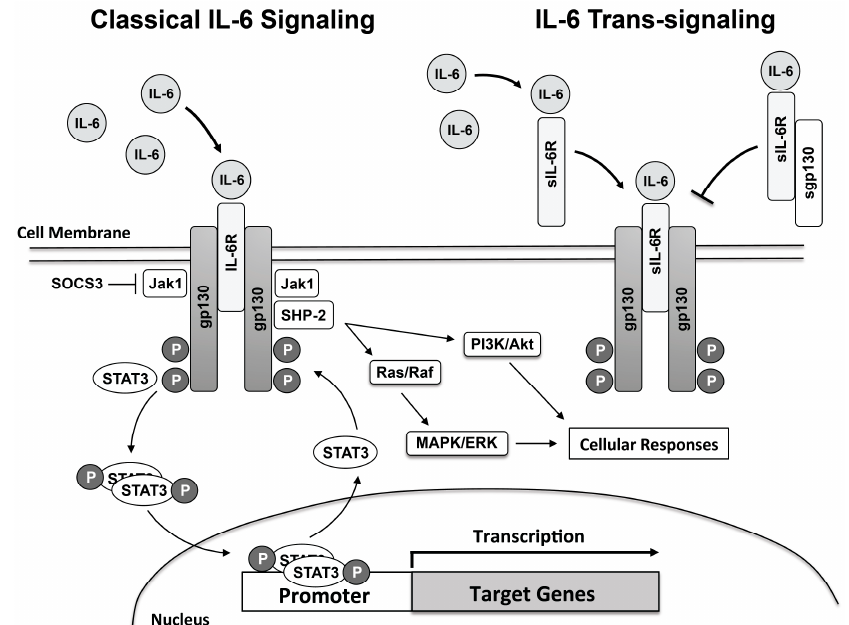
Figure 2. IL-6 signaling is a function of both classical IL-6 signaling and IL-6-trans-signaling. Classical IL-6 signaling involves IL-6 binding a membrane-bound IL-6 receptor (IL-6R), which facilitates dimerization of membrane-bound gp130. IL-6R lacks intrinsic signaling capability, however activated gp130 contains binding sites for recruitment and phosphorylation of signaling molecules such as Jak/STAT and SHP-2, which play important roles in transcription of IL-6 target genes, such as SOCS3. IL-6-trans-signaling occurs via IL-6 binding soluble IL-6 receptor (sIL-6R), which increases the half-life of IL-6 and serves as an important mechanism of IL-6 signaling in tissues that express gp130 but not IL-6R. Classical IL-6 signaling and IL-6-trans-signaling plays an important role in the diversity of IL-6 signaling. Expression of a soluble form of gp130 (sgp130) functions as an important endogenous inhibitor of IL-6 signaling by binding and preventing IL-6/sIL-6R complex binding and activation of membrane-bound gp130. Jak, Janus-associated Kinase; STAT, Signaling Transducer and Activator of Transcription; SOCS, Suppressor of Cytokine Signaling; PI3K, Phosphatidylinositol-4,5-bisphosphate 3-kinase; Akt, protein kinase B; ERK, Extracellular Signal-Regulated Kinase; MAPK, Mitogen-Activated Protein Kinase.